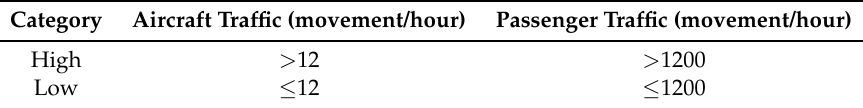
Table 5. Aircraft and passenger traffic